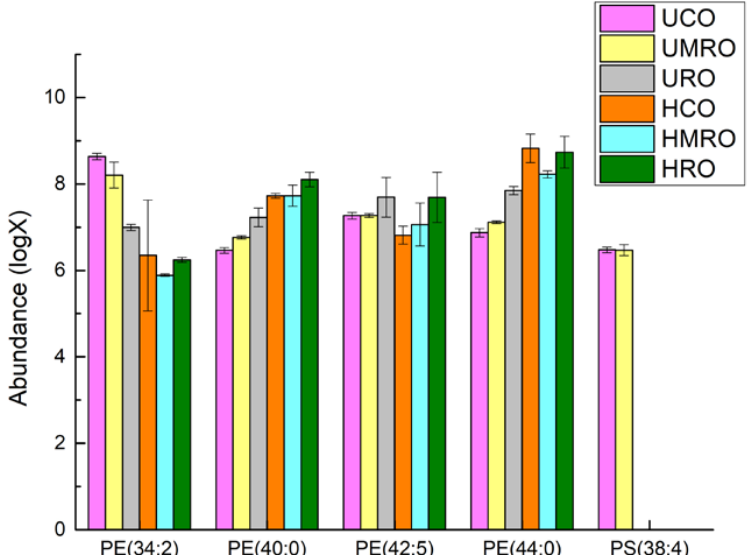
Figure 17. Transformation process between phosphatidylserine (C02737) and phosphatidylethanolamine (C00350) (https://www.genome.jp/entry/R02055, accessed on 31 March 2022). Reprinted with permission from KEGG Database. 2022, Kanehisa Laboratories.